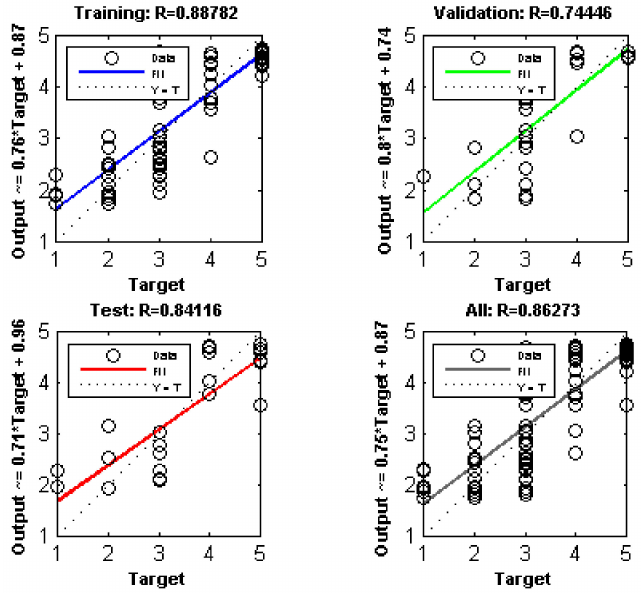
Figure 15. Goodness of fit for training, validation and testing